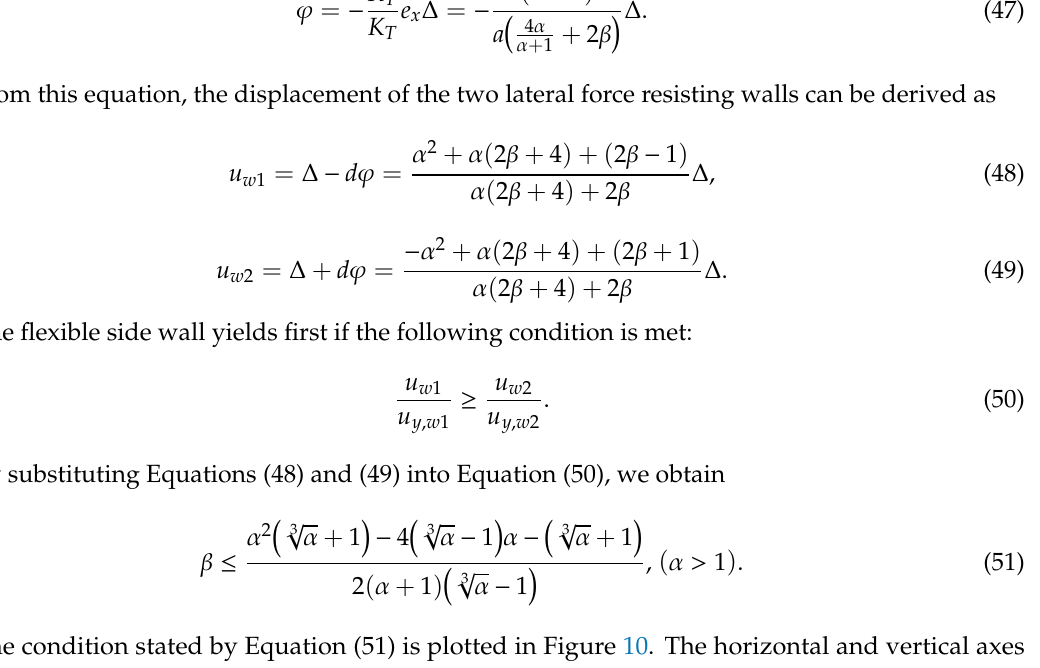
Figure 9. Example problem for the investigation of a transverse wall stiffness effect.